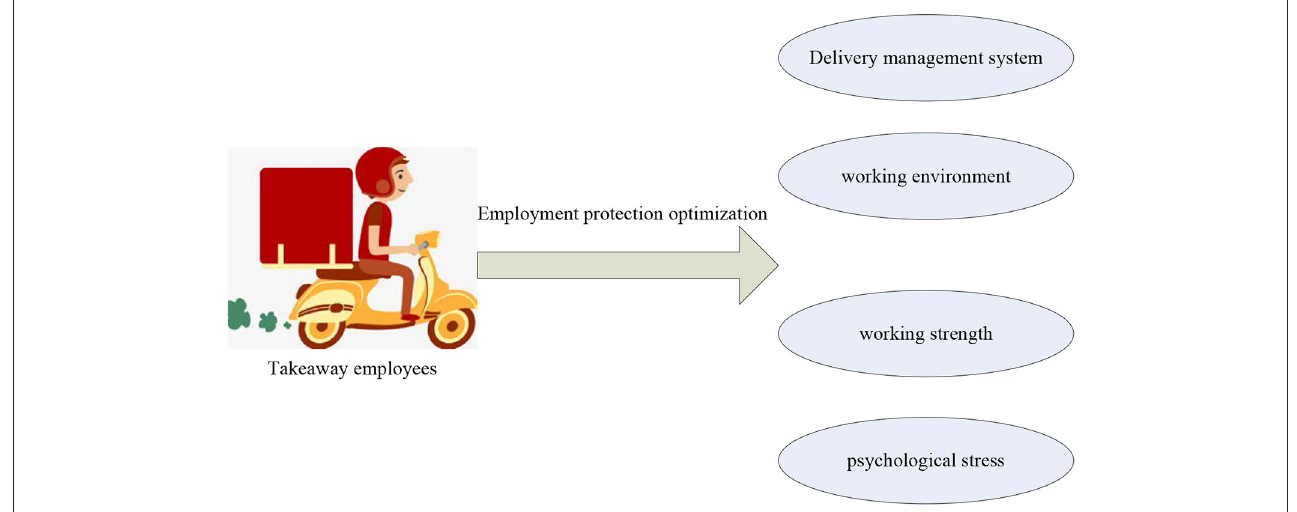
FIGURE3 Model diagram of occupational injury and employment protection optimization of takeout employees.